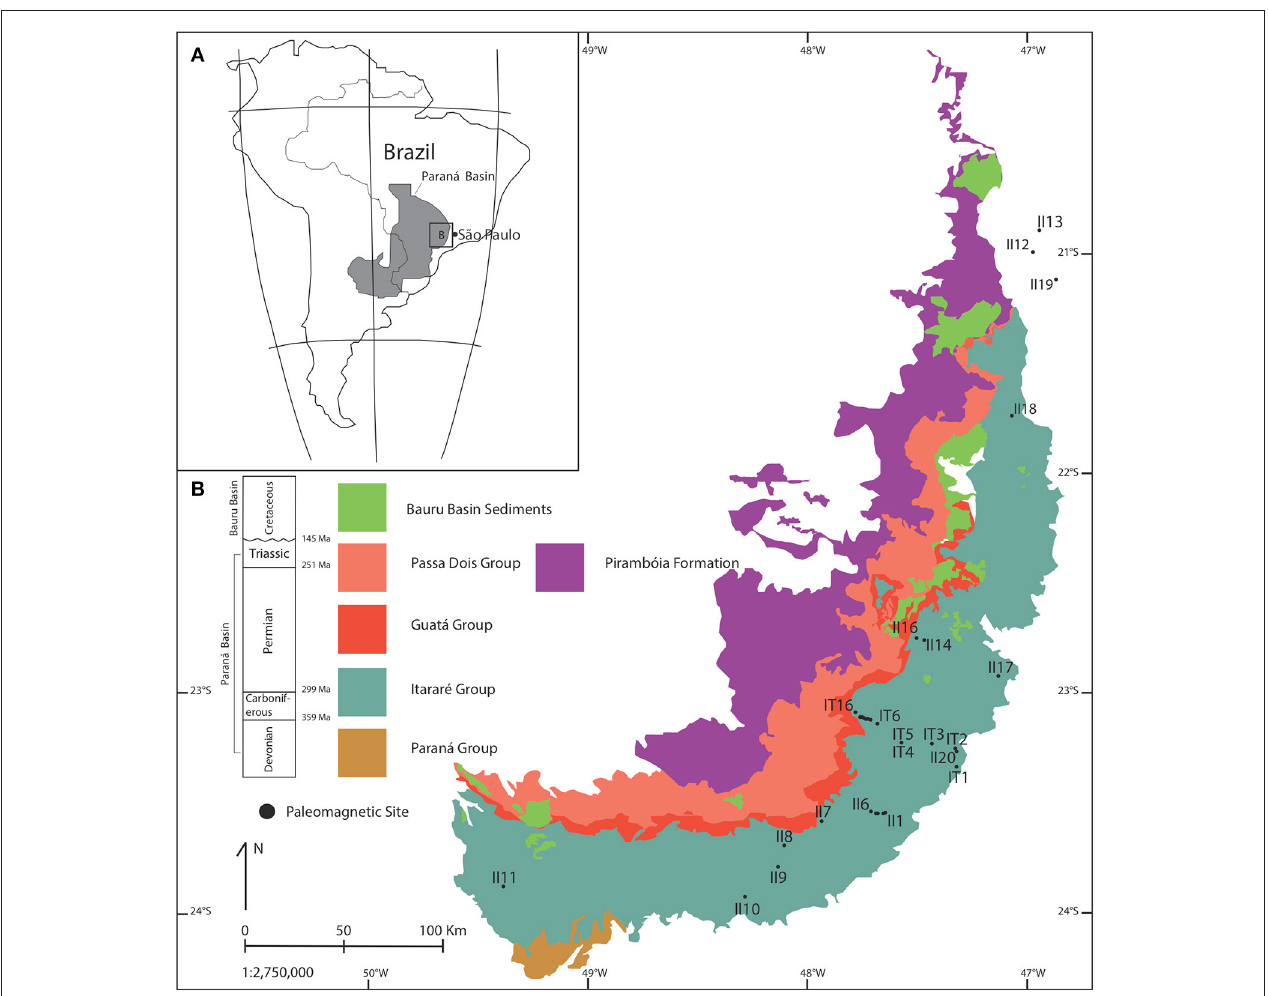
FIGURE 1 | Study area: (A) location of the study area within the Paraná Basin; (B) Site locations and outcropping geological formations within the state of Sao Paulo, Brazil. Note that three sites of the Itararé Group rocks (II12, II13, and II19) were collected in the neighboring state of Minas Gerais.